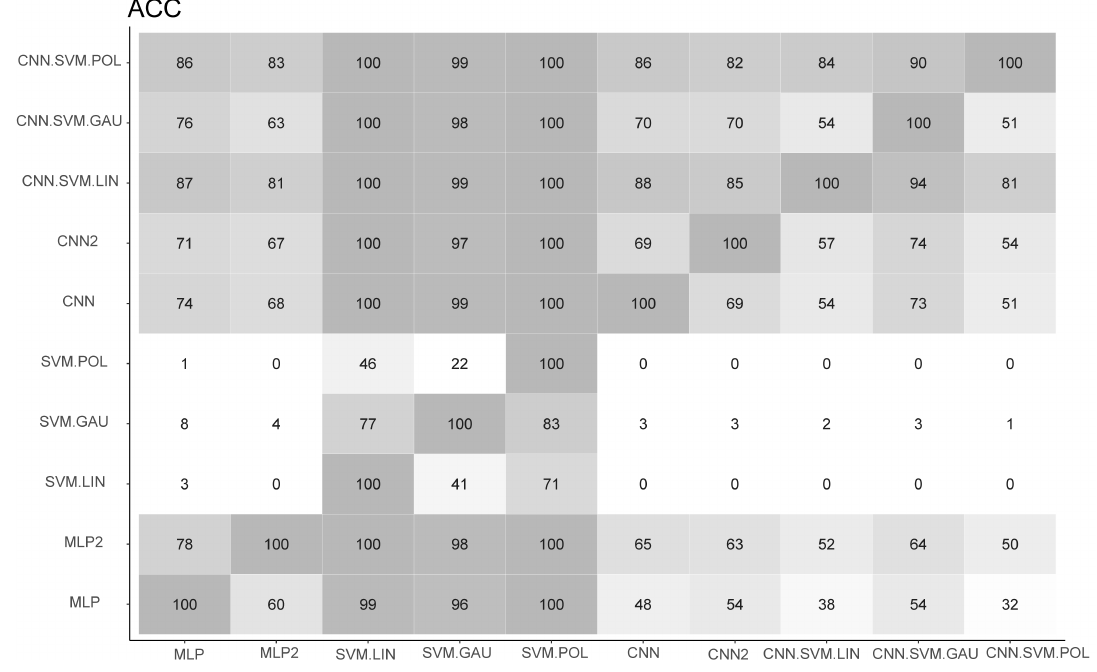
Figure 14. Number of times which a method obtained greater accuracy (ACC) than others. The count summarizes 100 holdout values. It is clear the superiority of CSVM Pol when it is compared with the other models. The darker is the table cell, the bigger is its score. Source: prepared by the